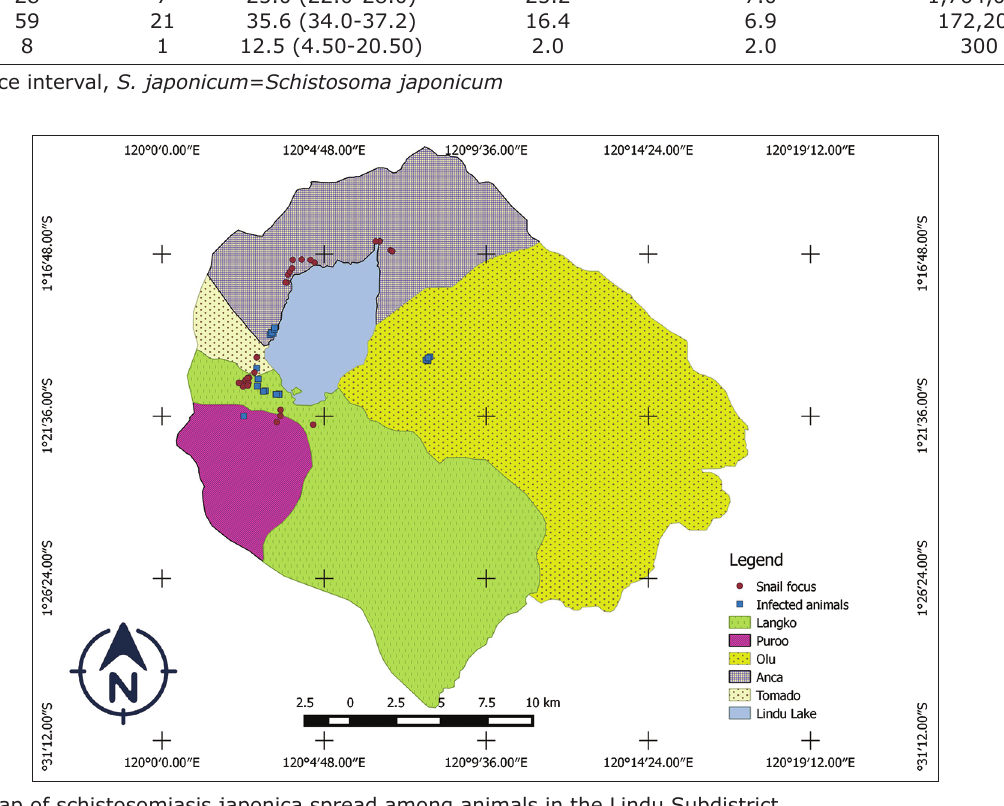
Figure-1: Map of schistosomiasis japonica spread among animals in the Lindu Subdistrict. [Source: Map was illustrated by Novericko Ginger